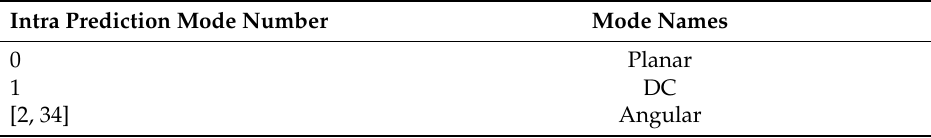
Figure 2. H.265/HEVC coding unit structure. Table 1. Intra mode number and its associated names.